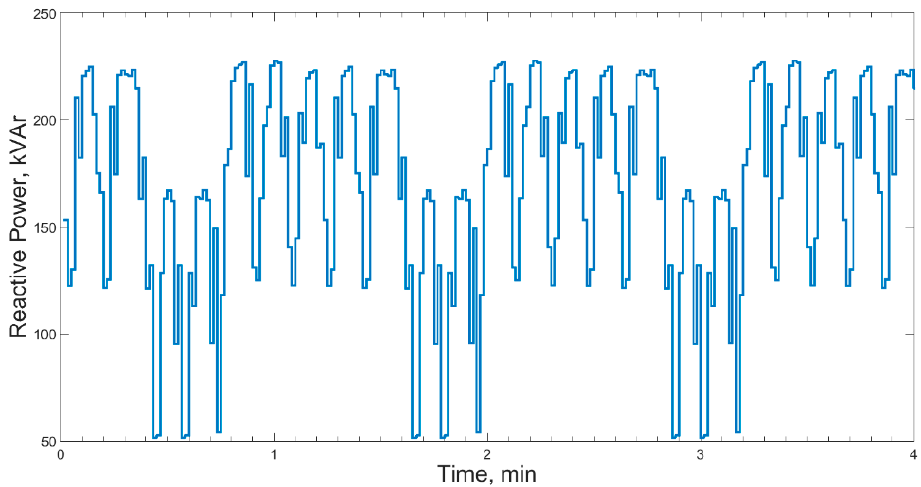
Figure 3. The total time curve of consumed reactive power.